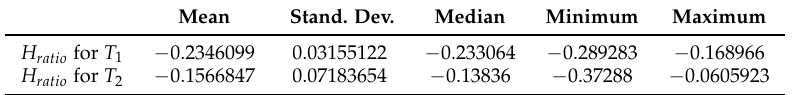
Table 3. Statistics of H ratio exp for the T 1 w and the T 2 w images for the 27 HCP LS volunteers. The H ratio exp are significantly negative for all images and hence all the restorations are successful. Mean Stand. Dev.